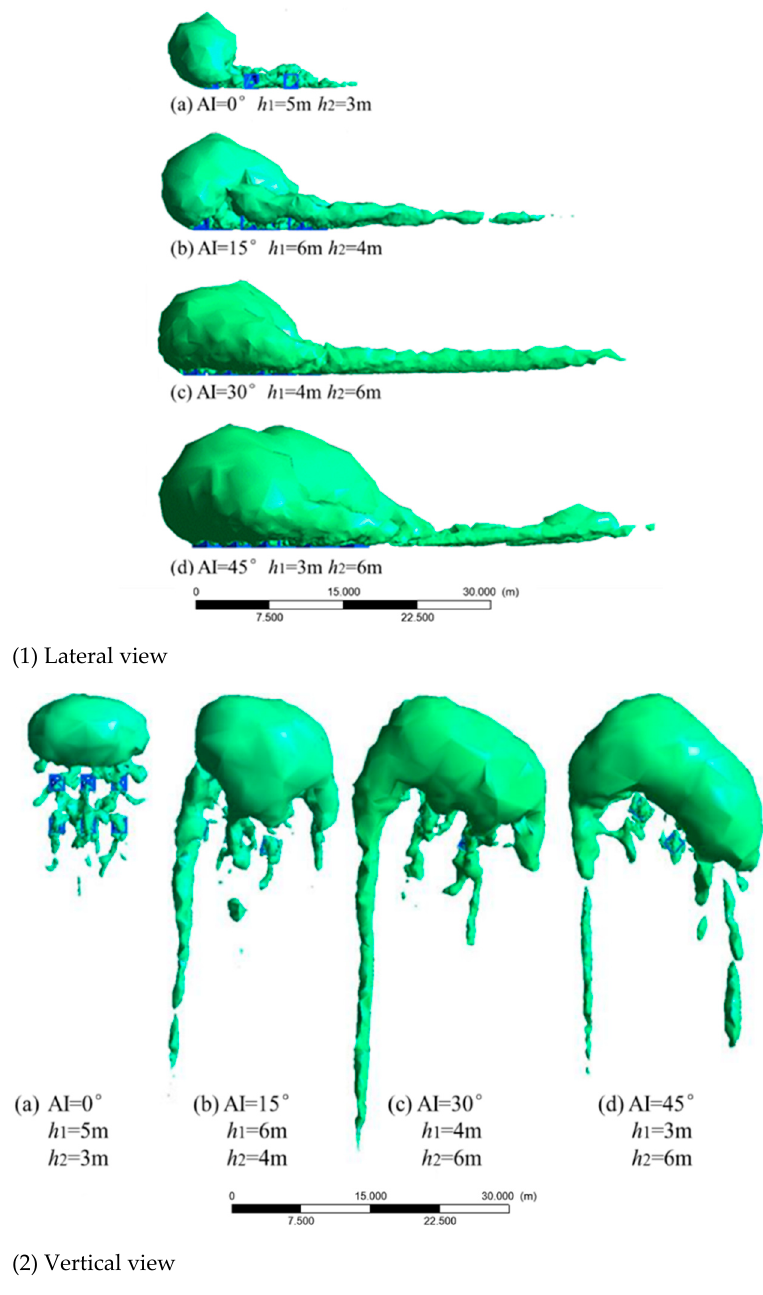
Figure 15. Upwelling volume of the optimal layout with the AI of 0°, 15°, 30°, and 45° (m 3 ) . The extent of the wake region generated by each UR is basically the same when the AI is 0°. With the deflection of the AI, the wake flow is gradually concentrated in the right rear of the right reefs and connected as a whole wake region (Figure 16). Combined with the analysis of upwelling volume, these results show that the flow field effect of UR is the most efficient when the AI is 45°.